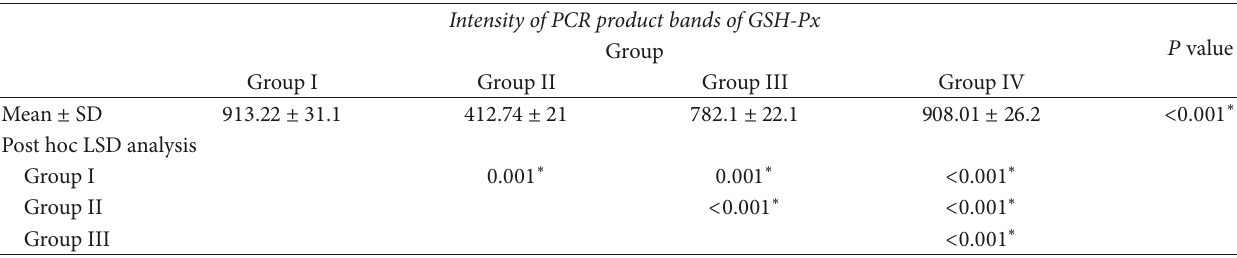
Table 6: One-way ANOVA statistical analysis of the intensity of the PCR product bands of GSH-Px among different experimental groups (𝑛 = 10) .